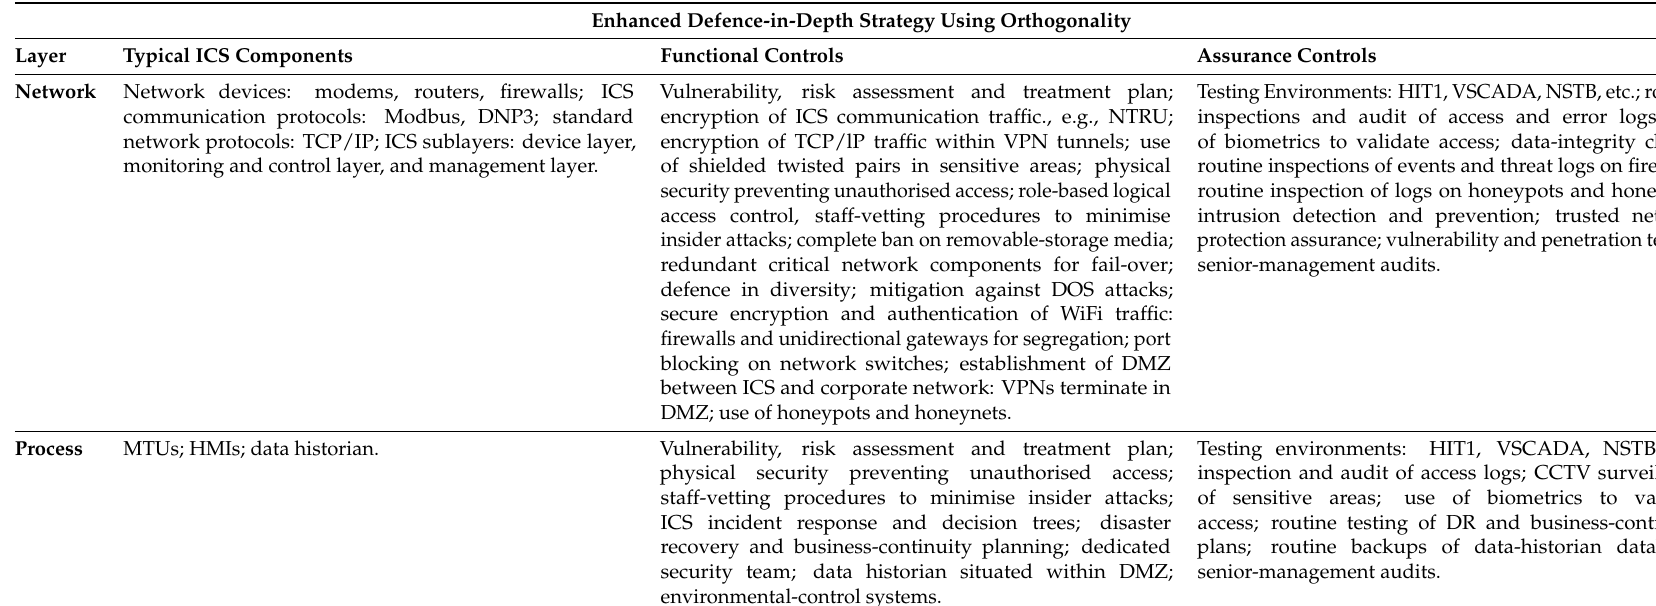
Table 3. Applying orthogonality to enhance ICS defence-in-depth